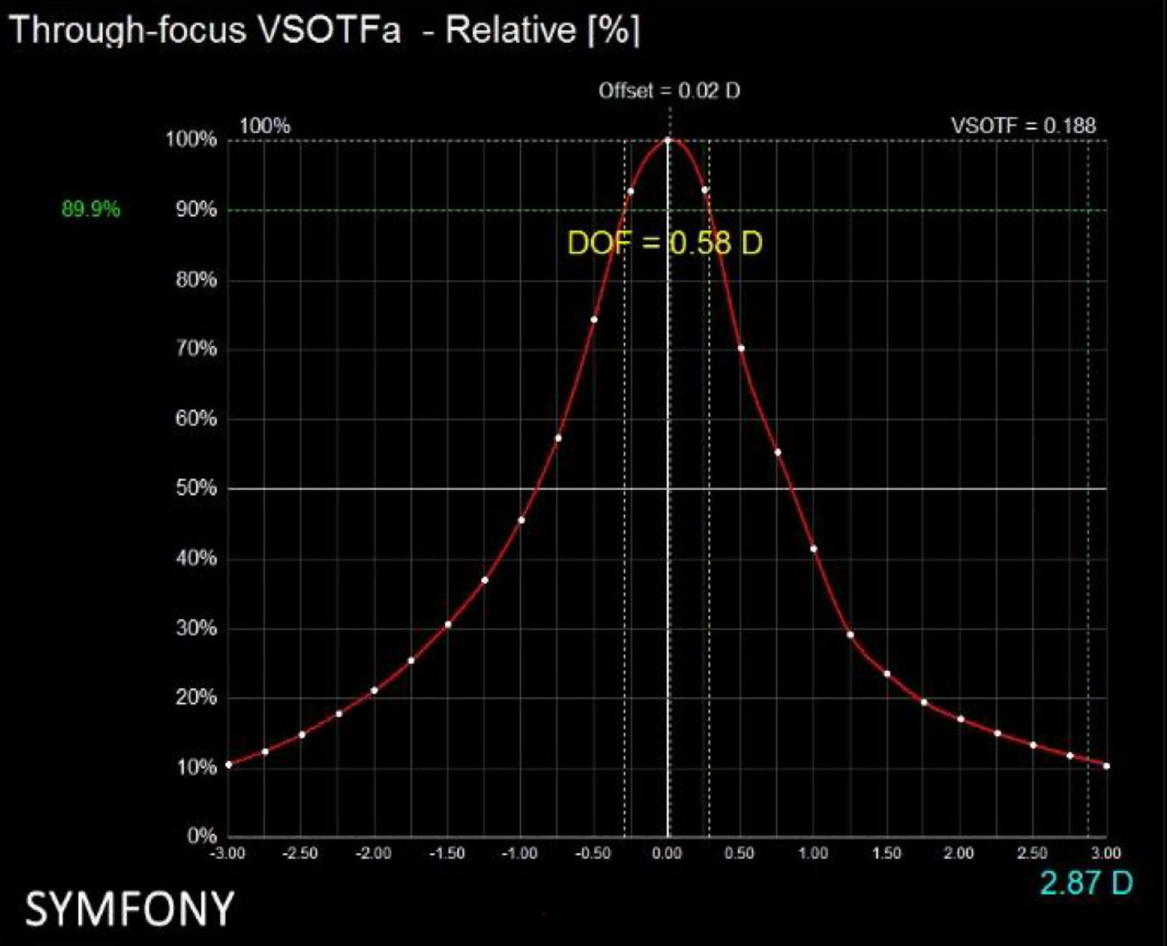
Figure 1. Report of DOF analysis in relative scale extracted from iTrace. The percentage of degradation on through-focus VSOTF is considered to calculate the DOF. In this case, a percentage of degradation of 90% was shown. Lower percentages represent a more permissive criterion of degradation, and will provide higher DOF